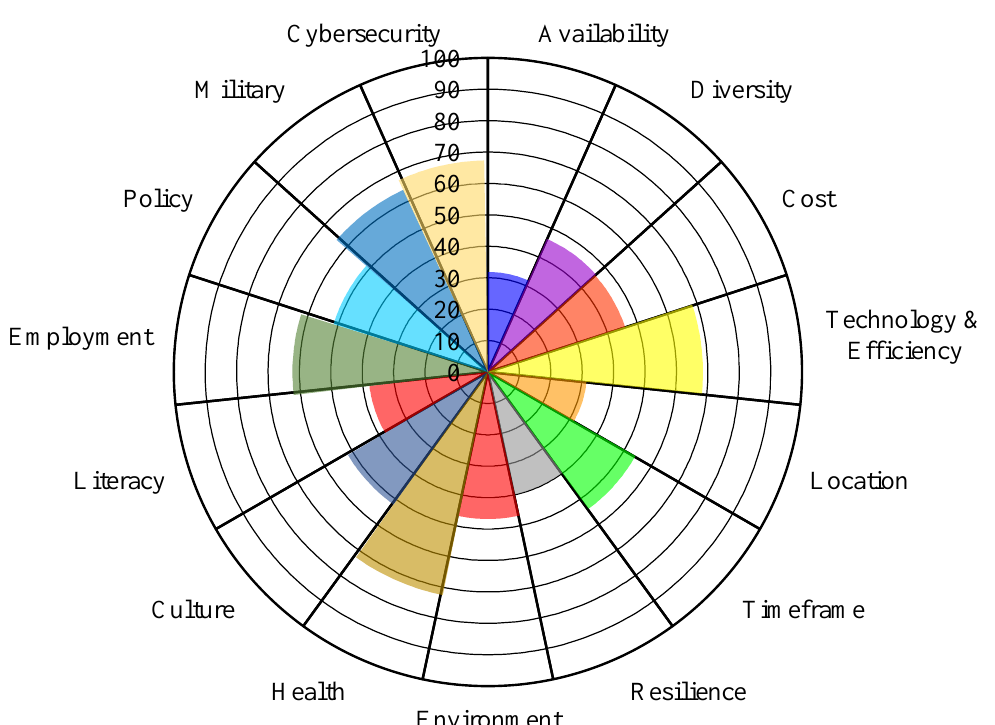
Figure 20. Detailed energy security view for China, values 0–100 represent worst to best.